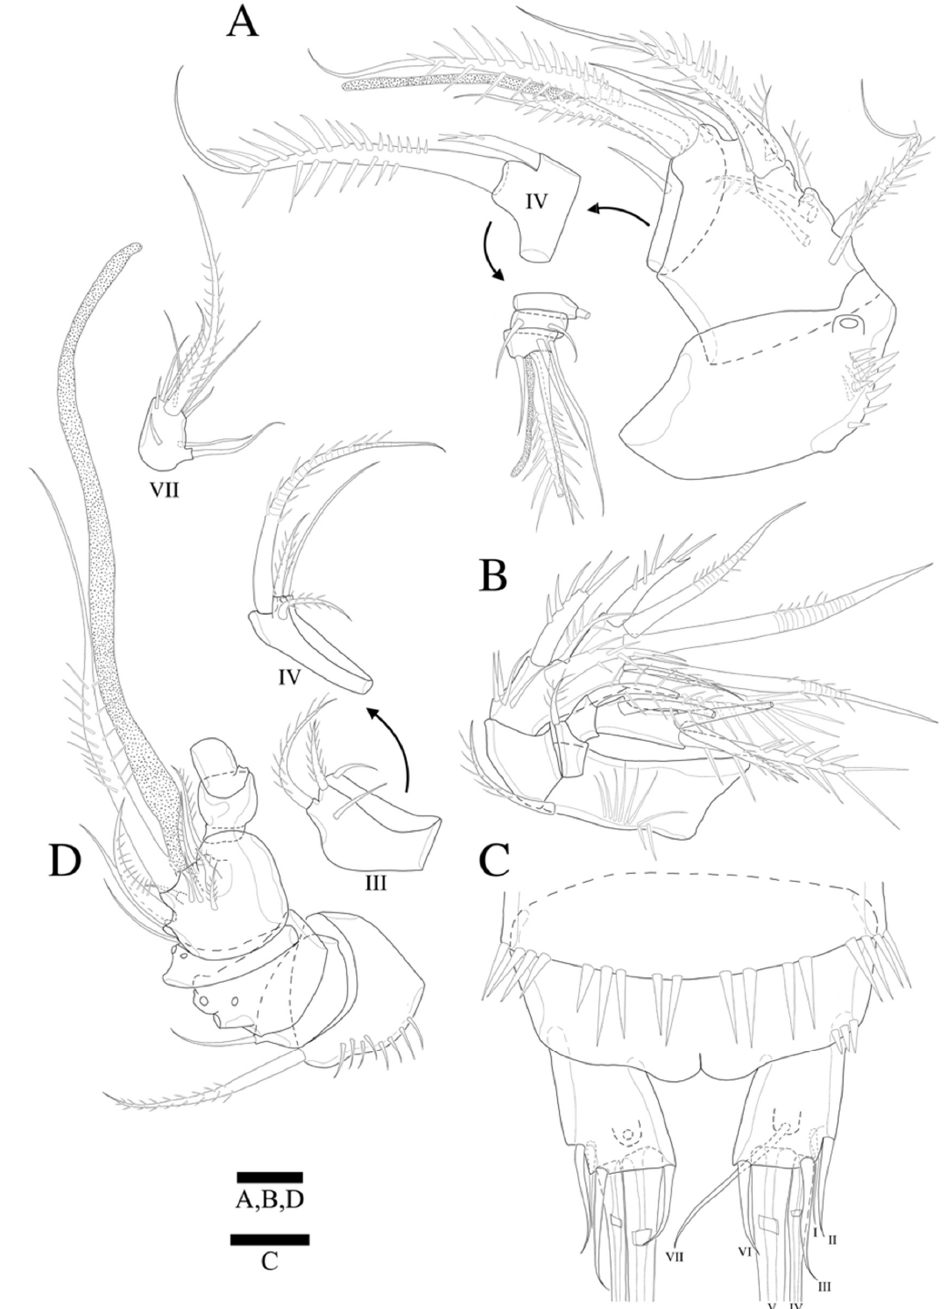
Figure 7. Zosime thistlei sp. nov. Female. ( A ) A1; ( B ) A2; ( C ) Anal somite and caudal rami. Male. ( D ) A1. Scale bars: 10 µm.